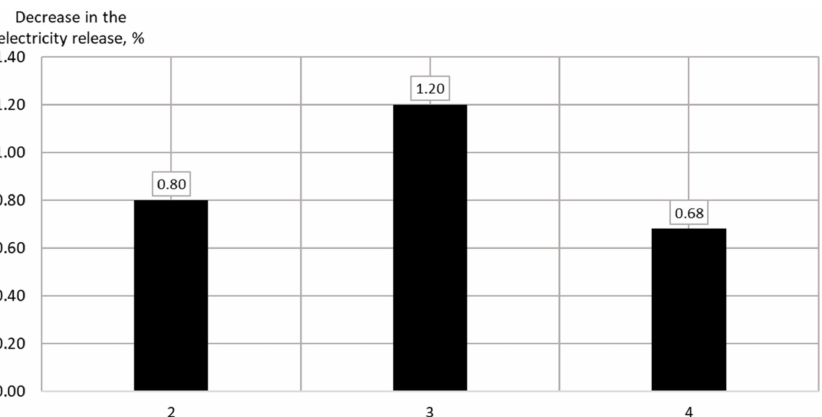
Figure 10. Decrease in the electricity release with integrated